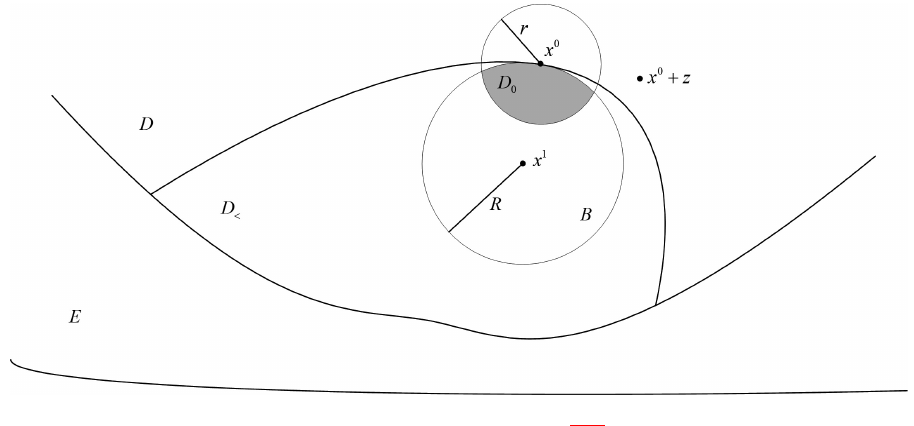
Fig. 1. Sketch for Theorem